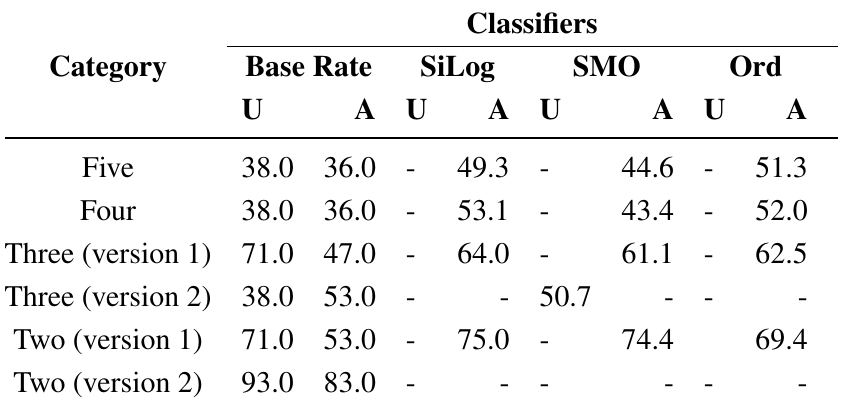
Table 2. Comparisons of significant improvements in classification accuracies in detecting the satisfaction score from conversational features (for both the user and annotator datasets).